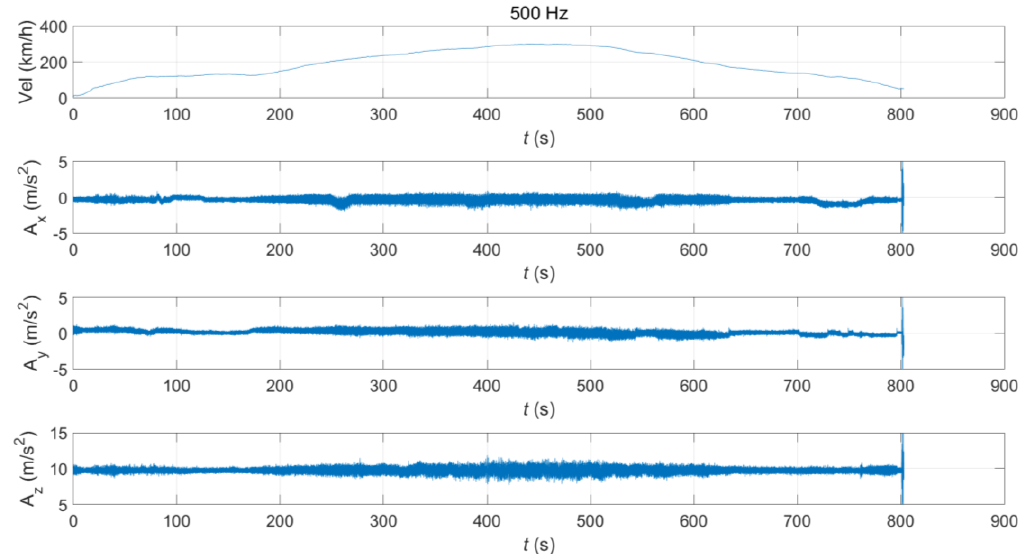
Figure 2. Korea Train Express (KTX) train vibration data measured by the onboard sensor.